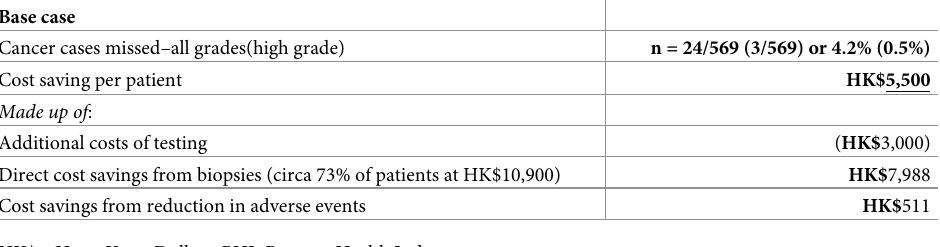
Table 3. Base-case results (PHI cut-off